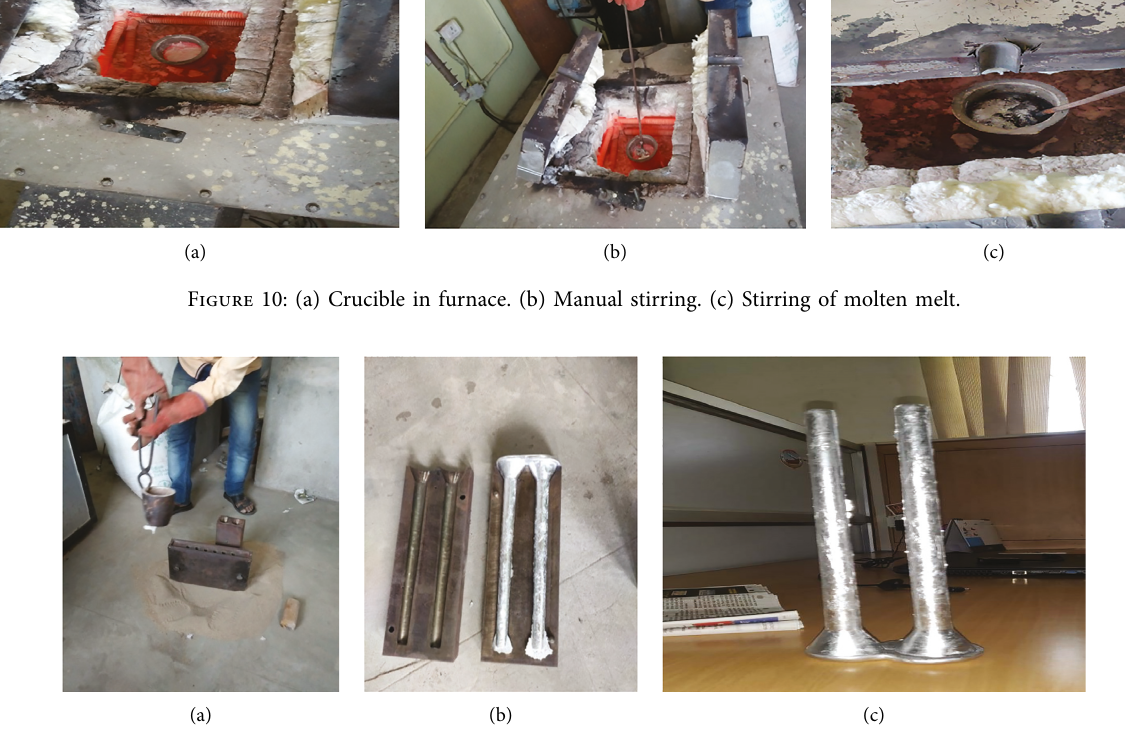
Figure 11: (a) Molten melt poured in die. (b) Molten melt cooled in die. (c) Removal of specimen from die. Table 2: Time taken for cooling at different temperatures. Temperature ( ° C) Time taken for cooling (min)